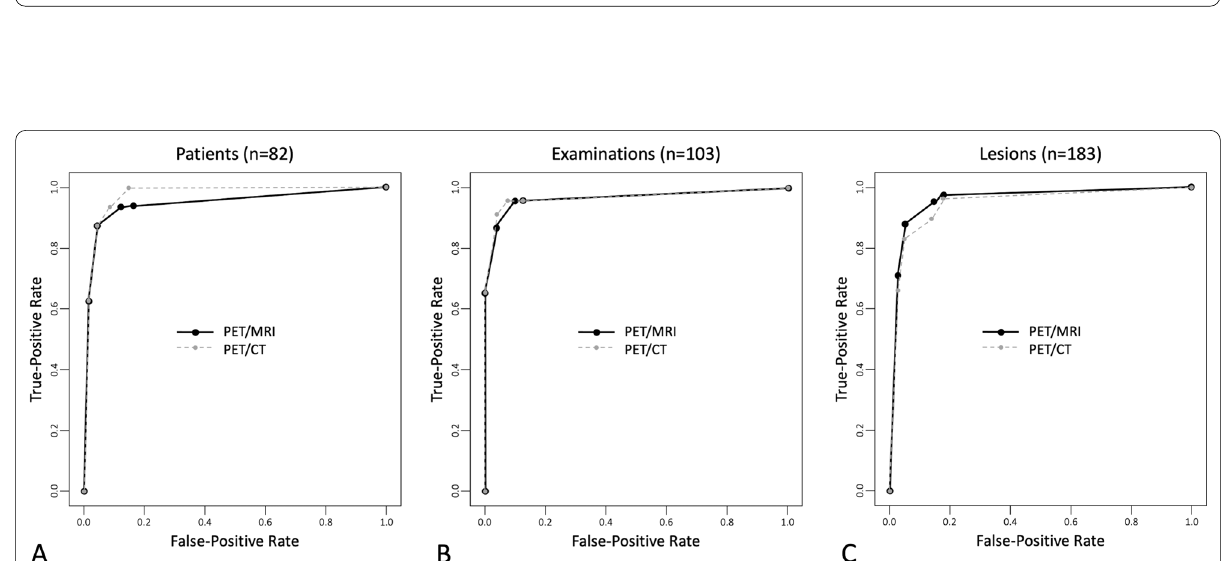
Fig. 2 Diagnostic performance of PET/MRI and PET/CT to detect distant metastases and distant synchronous cancers. A The AUC for the per patient analysis ( n 82) was 0.947 [0.927–1] for PET/MRI and 0.975 [0.950–1] for PET/CT, respectively. There was no statistically significant difference = between the two AUCs ( p 0.847). B The AUC for the per examination analysis ( n = 183) was 0.957 [0.928–0.987] for PET/MRI and 0.944 [0.910–0.979] for PET/CT, respectively. There was no statistically significant difference = between the two AUCs ( p =